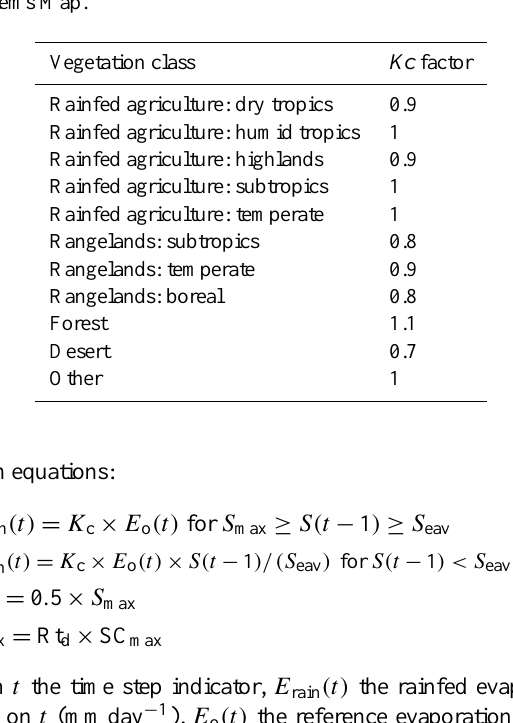
Table 1. Vegetation types derived from FAO’s Global Agricultural Systems